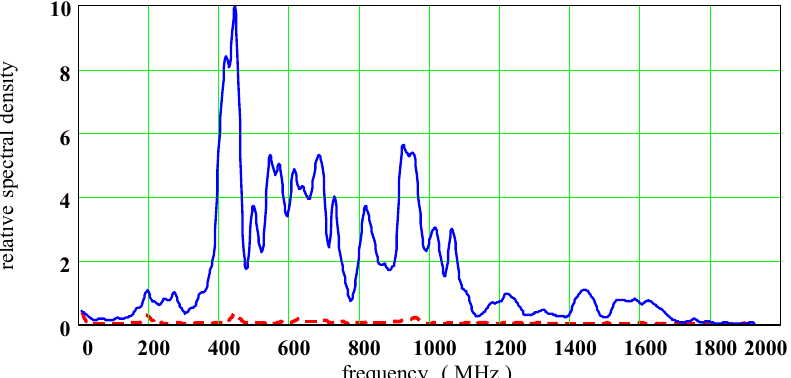
Figure 22. Comparison of the computed FFT spectral densities for the two signals in Figure 21. The same procedure followed for sensor S2 (which was several meters away from S1) gives a different perspective on the PD source. Figure 23a shows the portion of the S2 PD signal selected for FFT processing, and Figure 23b shows a section of S2 background noise. Figure 24 compares their relative spectral densities, showing that most S2 signal energy is concentrated in the range of 400–700 MHz.